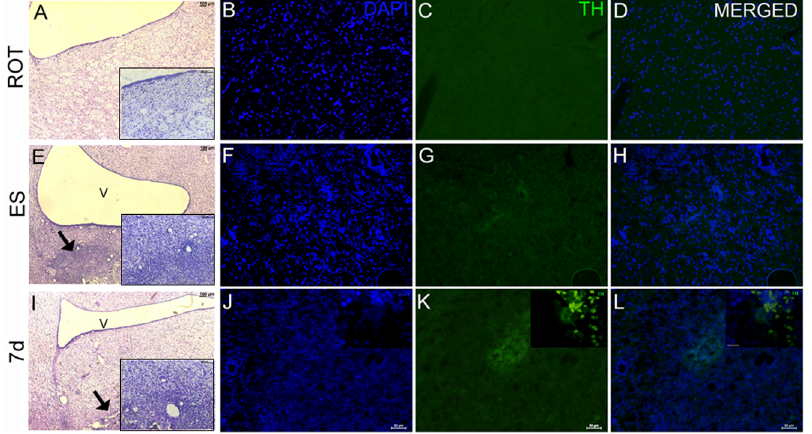
Figure 7. Characterization of the grafted cells in the striatum. Striatal sections of the rotenone-infused control (ROT), embryonic stem cells transplanted animal (ES) and 7 days differentiated cells transplanted animal (7 d) were processed for presence of dopaminergic cells positive for tyrosine hydroxylase (TH) immunoreactivity. Sections were stained with cresyl violet (A, E and I) for localization of neurons (Scale bars for both inset as well as the main frame are 100 m m), and with DAPI for nuclei (B,F,J). Sham transplanted (ROT; B–D); undifferentiated embryonic stem cells transplanted (ES; F–H) and 7 days differentiated cells grafted (7 d; J–L) striatal images are shown. Scale bar is 50 m m for these figures. Scale bar for the magnified images showing TH positive cells, in the right hand corners of the lower panel is 10 m